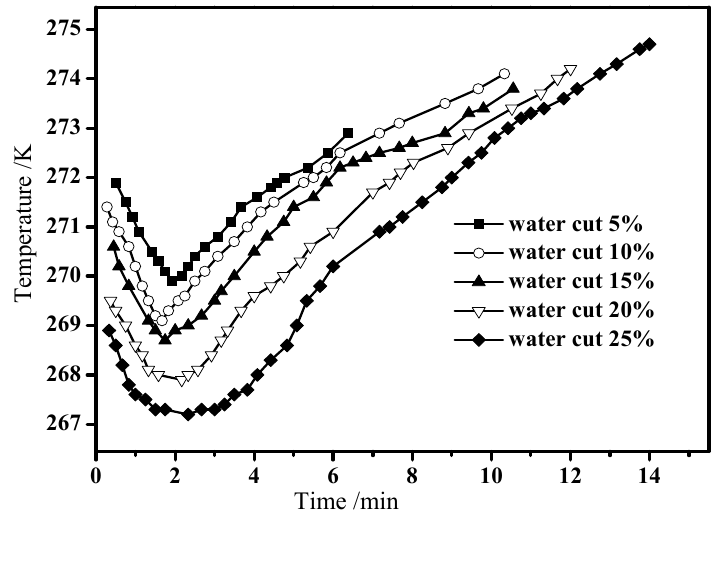
Figure 10. Variation of temperature in the process of natural gas hydrate dissociation in